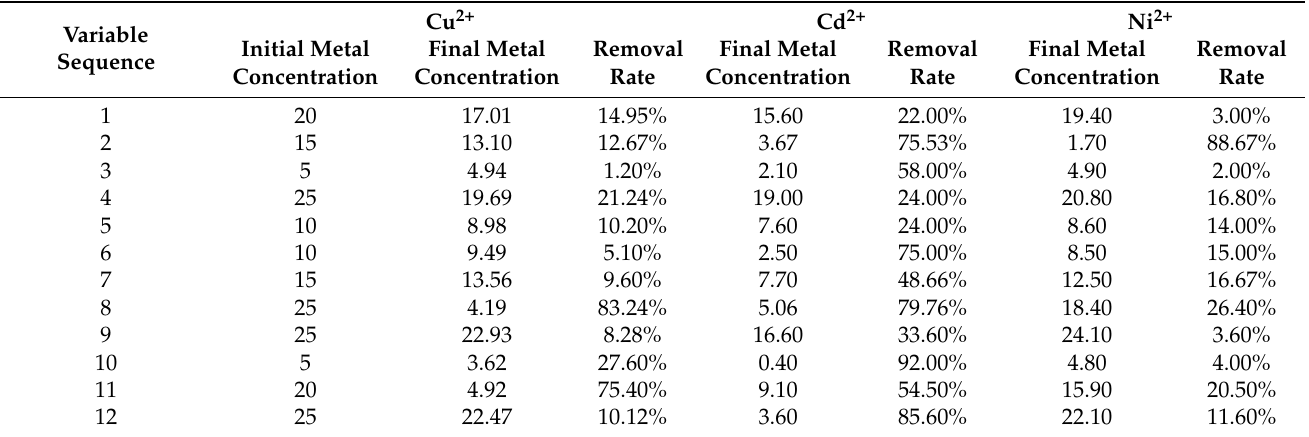
Table 2. Removal Rate of Copper, Cadmium and Nickel by Algae